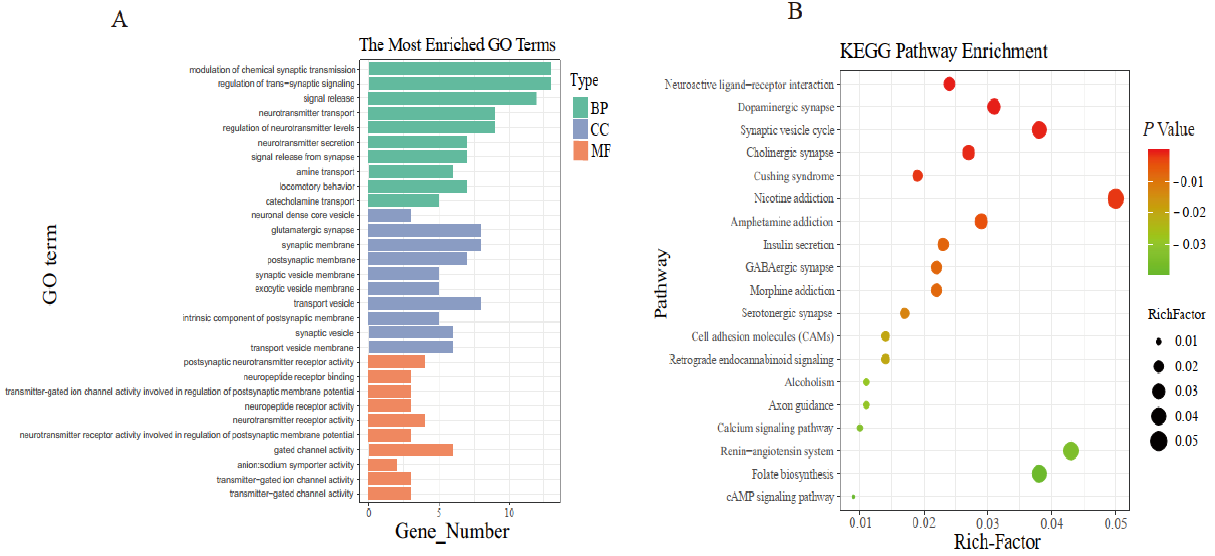
Figure 3. ( A ) Gene Ontology (GO) terms enriched by DEGs and ( B ) Kyoto Encyclopedia of Genes and Genomes (KEGG) pathways enriched by DEGs. “BP” means biological process; “CC” means cellular component; “MF” means molecular function. The Rich-Factor is the ratio of the number of DEGs in the pathway and the total number of genes in the pathway.